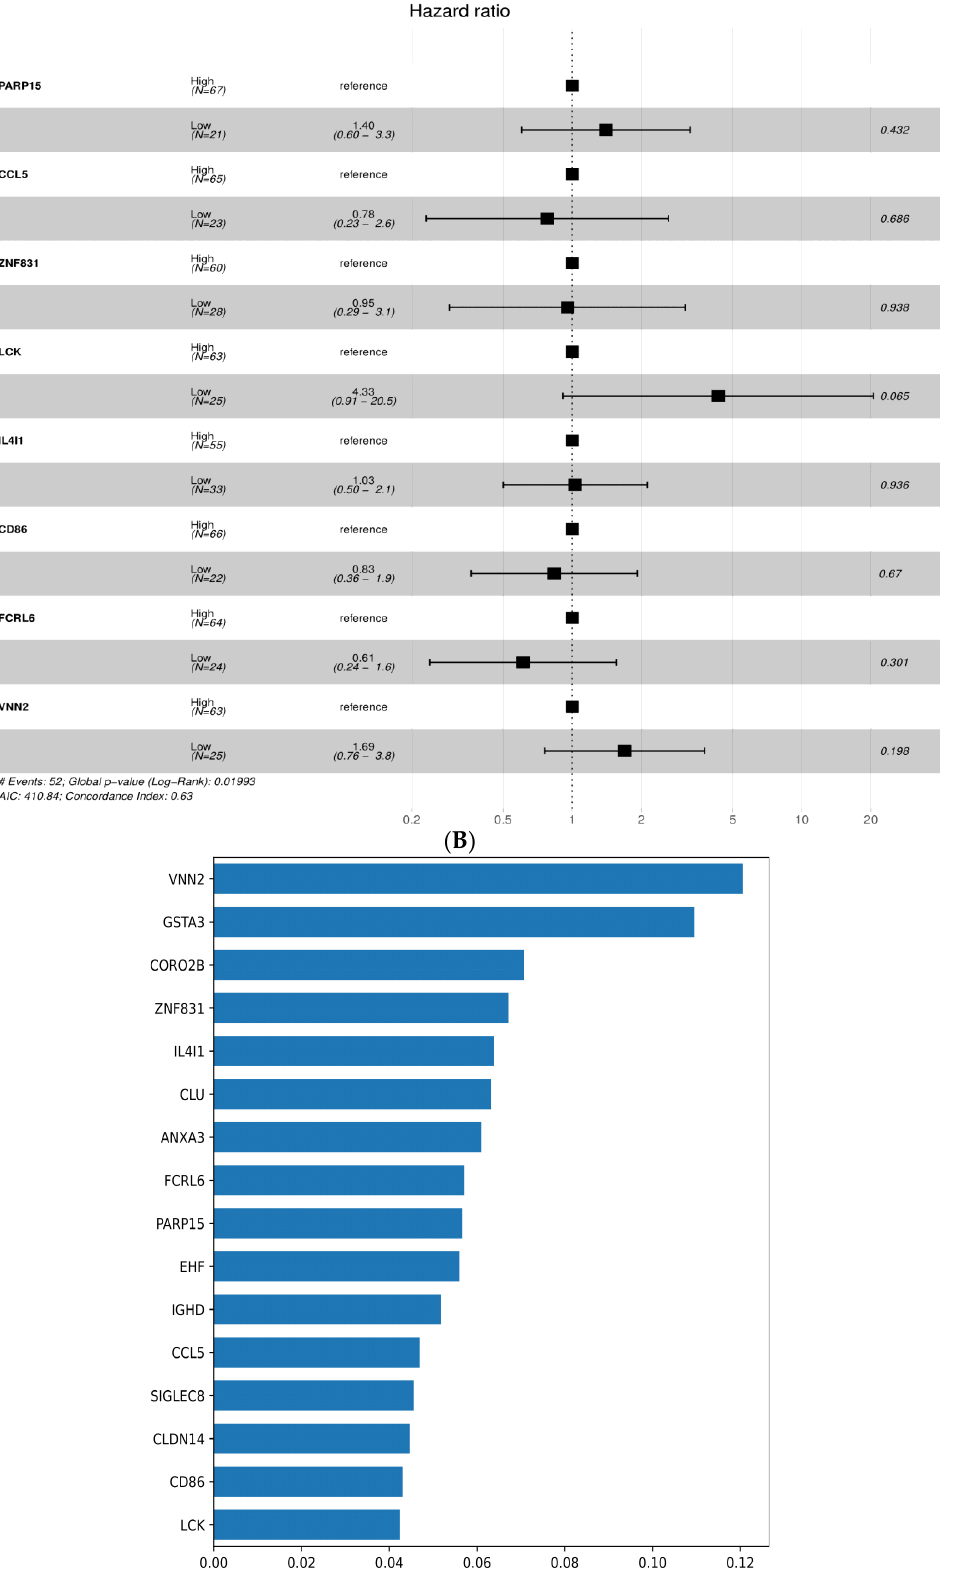
Figure 6. Overall survival value of survival-related genes and RFC16 model: ( A ) Kaplan–Meier plots of overall survival related-genes (CCL5, IL4I1, VNN2, PARP15, LCK, ZNF831, CD86, and FCRRL6). All the genes were significant based on best cutoff value. ( B ) Cox proportional hazard model of the